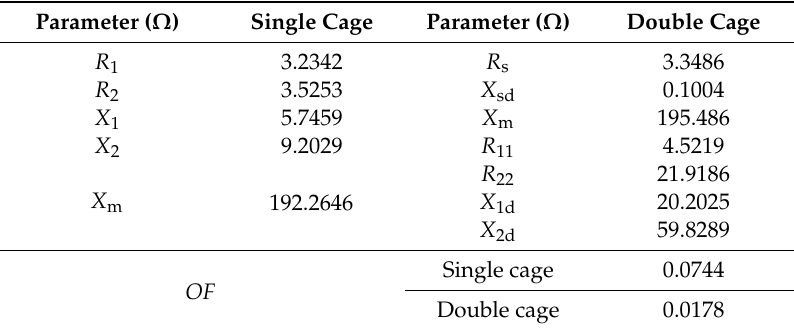
( d ) Figure 11. Experimental results: ( a ) Phase current versus slip; ( b ) power factor versus slip; ( c ) active power versus slip; and ( d ) convergence characteristics of considered machine when applying the proposed algorithm.